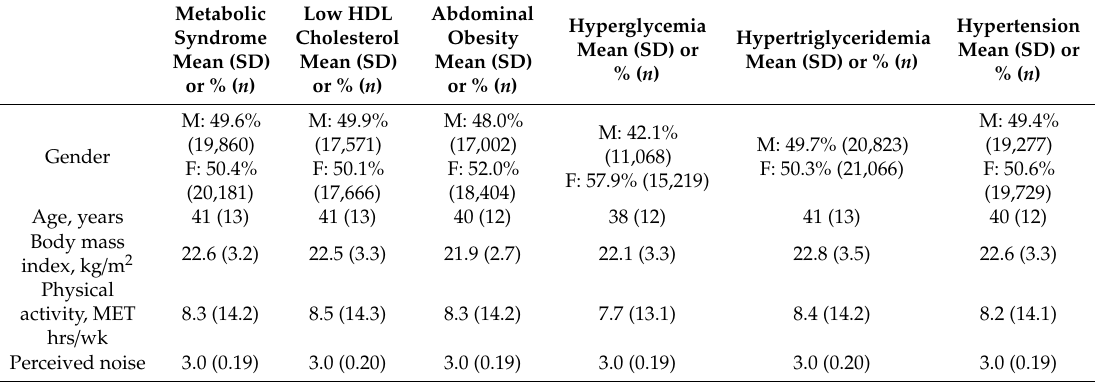
Table 1. Baseline characteristics of the MJ participants analyzed for metabolic syndrome and its components.